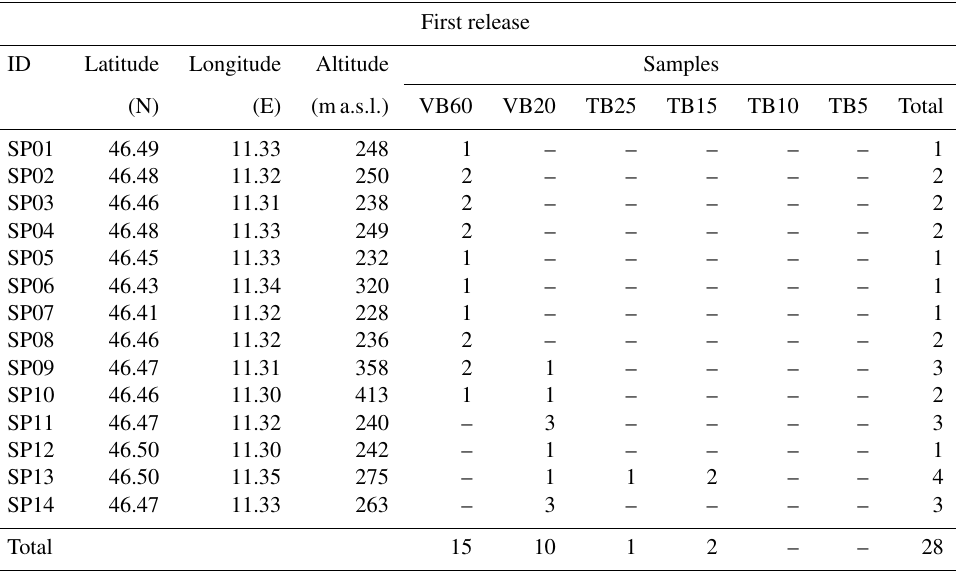
Table 4. Geographical coordinates of the sampling points (SP) along with number of samples of ambient air collected during the first release of BTEX (VB: vacuum-filled glass bottle; TB: PVF bags). The numbers after VB and TB indicate the duration in minutes of the